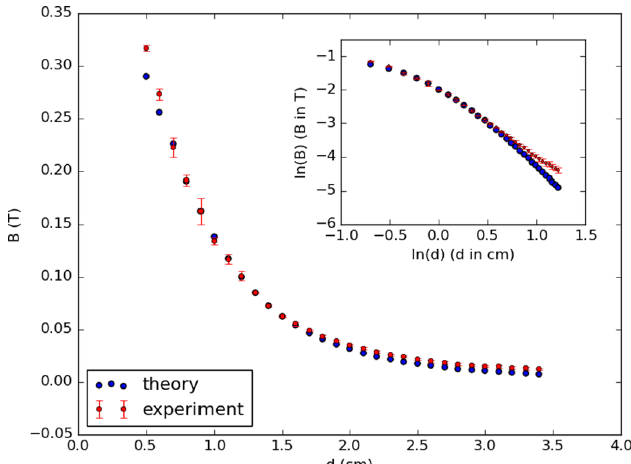
Fig. 2. Main panel : The magnetic fi eld of the large rectangular magnet as a function of distance from its center. The red points show the experimental values and the blue points the theoretical values. Inset : The same dependence in a logarithmic plot. The theoretical values were calculated numerically by using the experimental value at d =0.9cm to determine the magnetization of the magnet, considered homogeneous. The validity of this approach is discussed in the